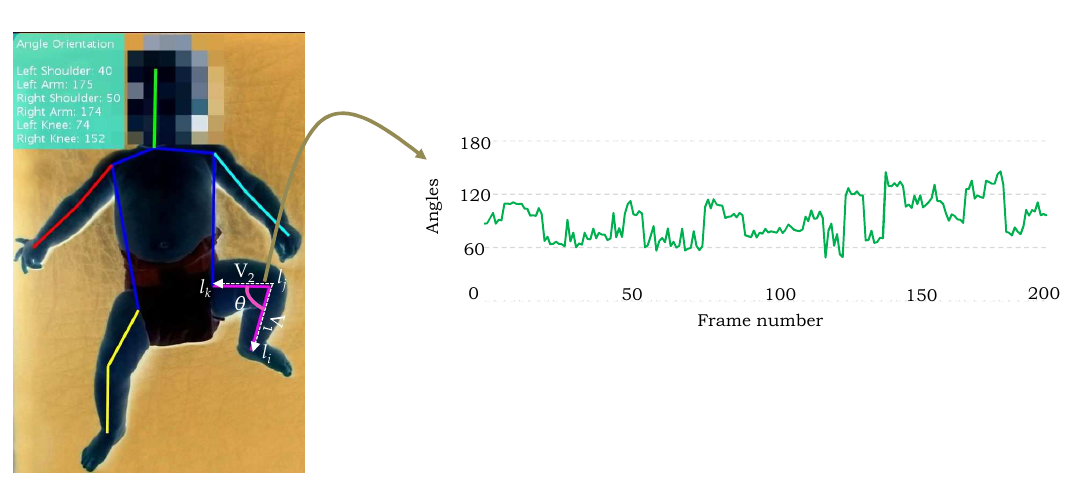
Figure 5. An example of angle computation at the predicted left knee joint and its tracking in the subsequent 200 frames. The angle orientations at other joints are annotated at the upper-left corner of the test image. The patient body is shown in negative to preserve the privacy of the